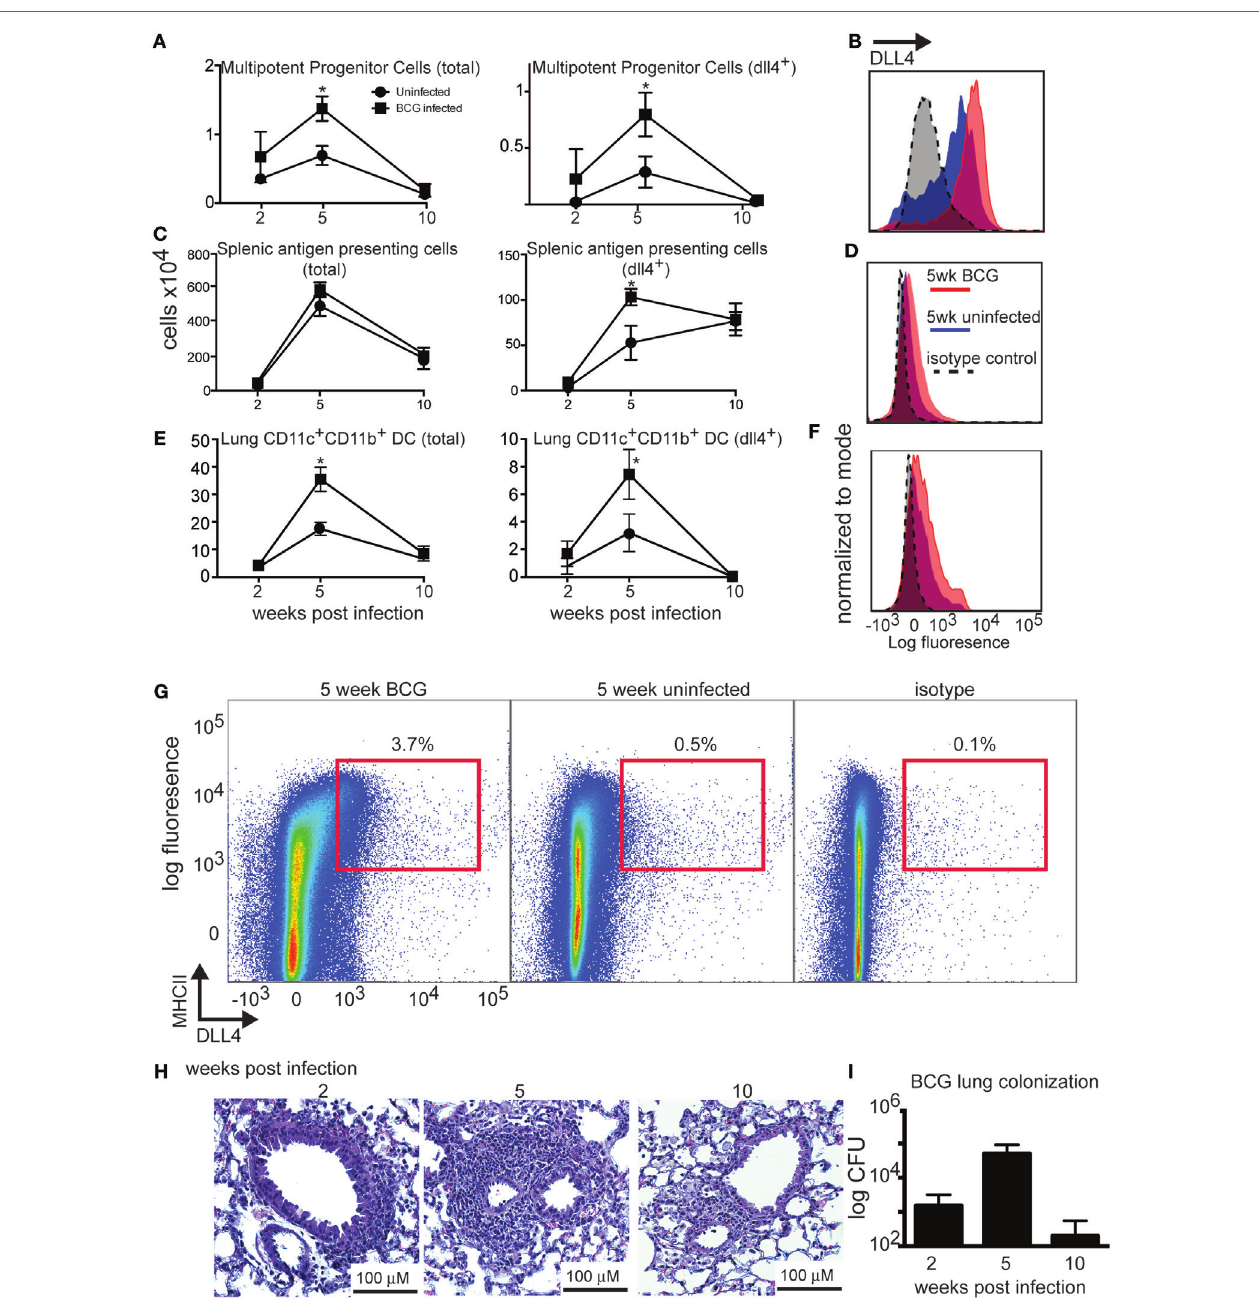
FigUre 1 | increase in number of cells expressing delta-like 4 in mice infected with Mycobacterium . (a,c,e) Increase in total and dll4 + multipotent progenitor cells (lin − ckit + sca1 + flt3 + ), dll4 + splenic DC subsets (pooled together from CD4 + CD11c + MHCII + , CD8a + CD11c + MHCII + , and CD4 − CD8 − B220 − CD11b + CD11c hi MHCII + populations), and dll4 + lung conventional dendritic cells (autoflourescent − CD11c + CD11b + MHCII + ) at 5 weeks post-infection with